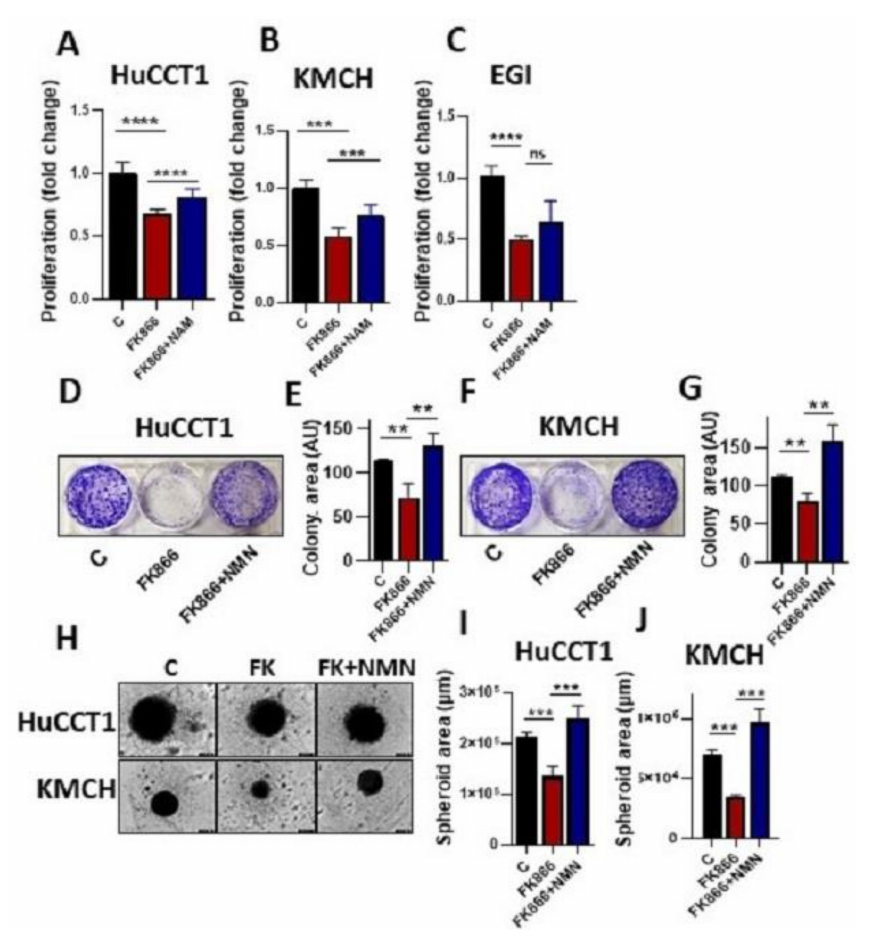
Figure 3. Supplementation with NAD reverses the effects of the FK866. ( A – C ) HuCCT1, KMCH, and EGI cells were treated with FK866 (10 nM) with or without NMN (10 µ M), and cell growth assay was performed using MTS assays. ( D – G ) Colony formation assay was conducted in HuCCT1 and KMCH cells treated with FK866 for 10 days with or without NMN treatments. Colony area was measured by ImageJ analysis and represented as bar graphs. ( H – J ) Spheroid formation assay was performed in CCA cells (HUCCT1 and KMCH) in the presence of FK866 (10 nM) with or without NMN (10 µ M). Images were captured and analyzed by IncuCyte. (** p < 0.01, *** p < 0.001, **** p < 0.0001 and ns,